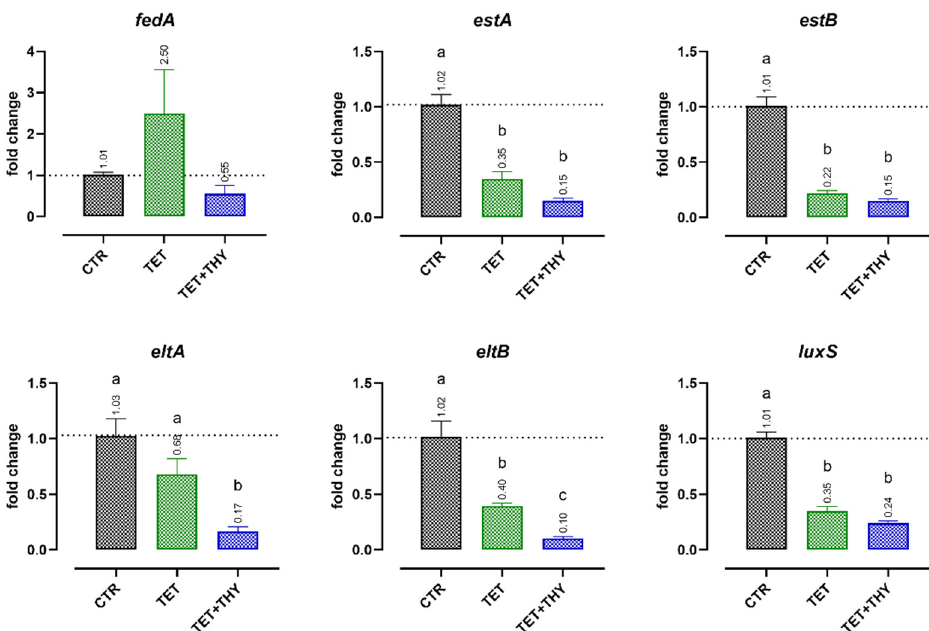
Figure 3. Effects of tetracycline (64 mg/L, TET) or a combination of tetracycline and thymol (MIC/4, 0.47 mM, TET + THY) on ETEC 95′s and ETEC 97′s expression of virulence genes related to adhesion ( fedA ), heat-stable toxin expression ( estA and estB ), heat-labile toxin expression ( eltA and eltB ), and quorum sensing ( luxS ). Data are expressed as the means of the three technical replicates of the two studied strains, with the SEM reported as vertical bars. For each gene, data were analyzed by one- way ANOVA with Tukey’s multiple comparison test; superscript letters (a, b, c) indicate significant differences among the groups ( p < 0.05).